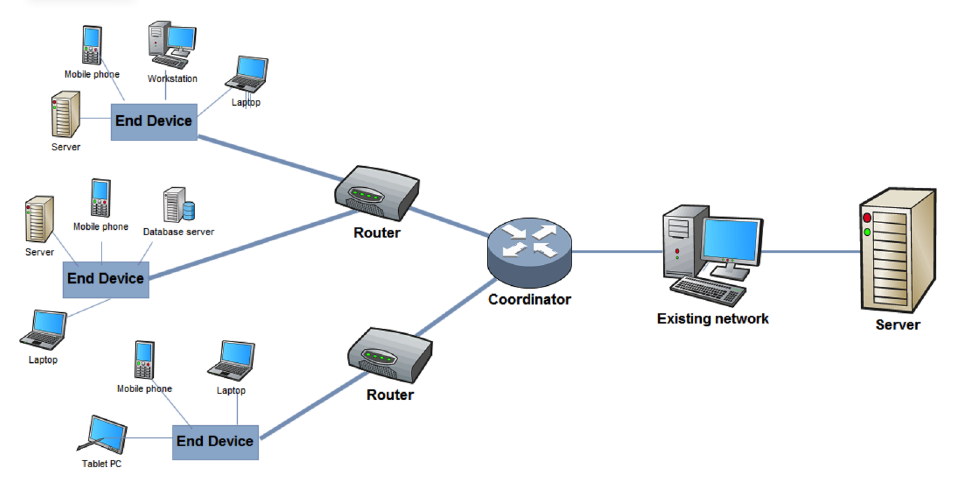
Figure 2. Zigbee Network